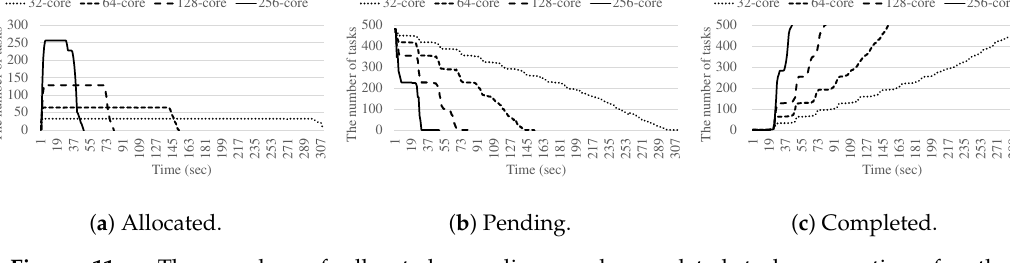
Figure 11. The number of allocated, pending, and completed tasks over time for the 410.bwaves benchmark.